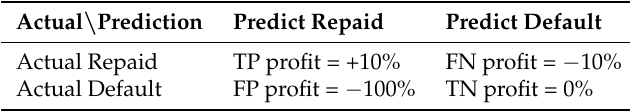
Table 5. Confusion matrix and associated